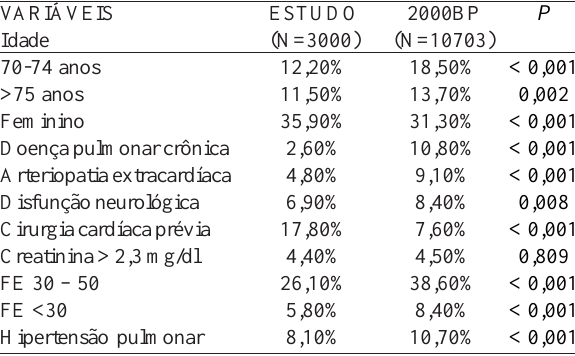
Tabela 2. Prevalência dos fatores de risco no Grupo Estudo, comparado aos fatores de risco da população do 2000 Bernstein Parsonnet.